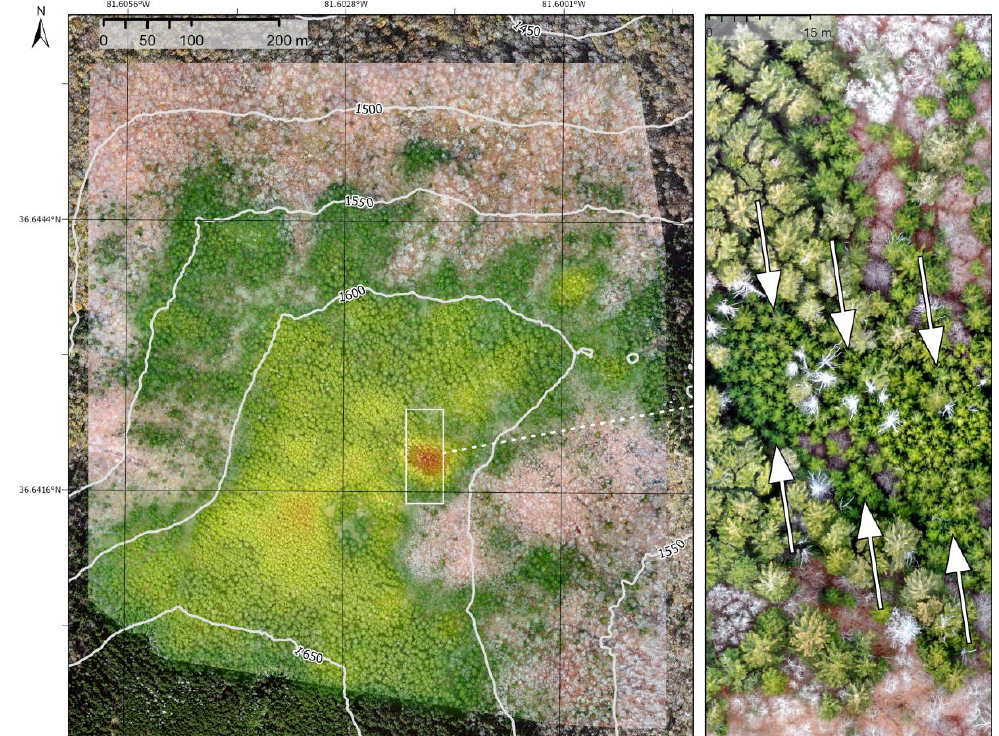
Figure 5. Left : Kernel density of all red spruce individuals (live, declining, and dead) within the Whitetop sample plot, highlighting more densely concentrated spruce saplings. Red areas indicate concentrations of spruce. A 2.5 m resolution pixel size was set to represent the approximate horizontal area of spruce. Right : close-up of spruce sapling release under dead overstory trees indicated by white